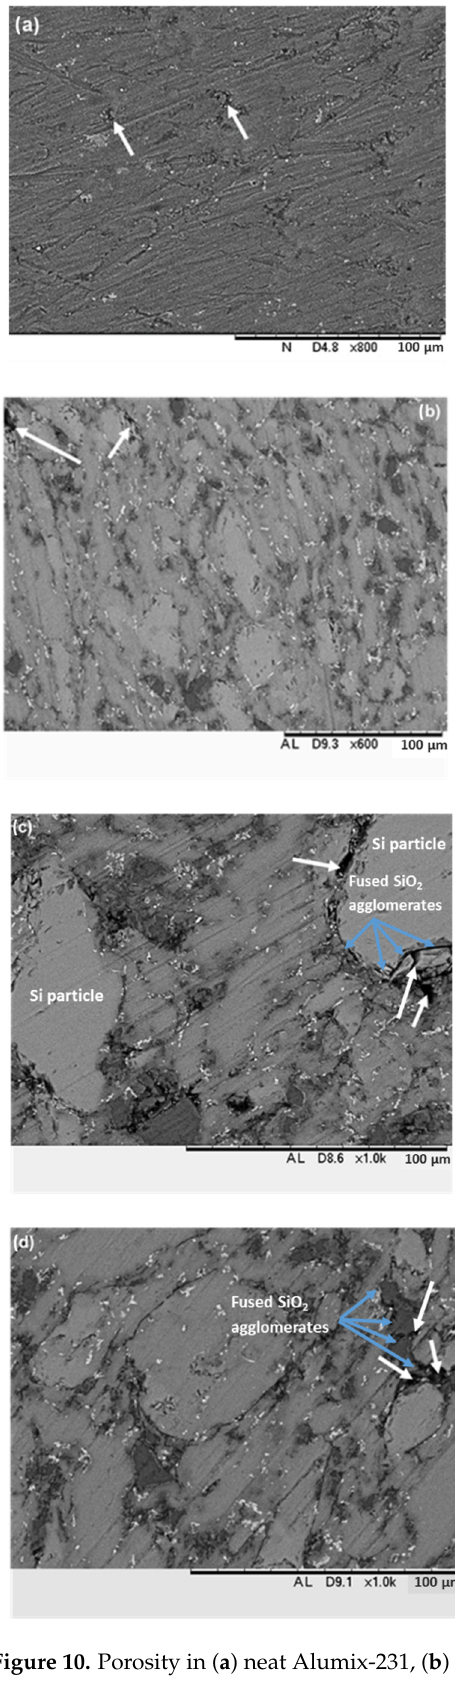
Figure 10. Porosity in ( a ) neat Alumix-231, ( b ) MMC-10 vol.%, ( c ) MMC-15 vol.% and ( d ) MMC-20 vol.%. White arrows show pores; blue arrows point to fused silica agglomerates.